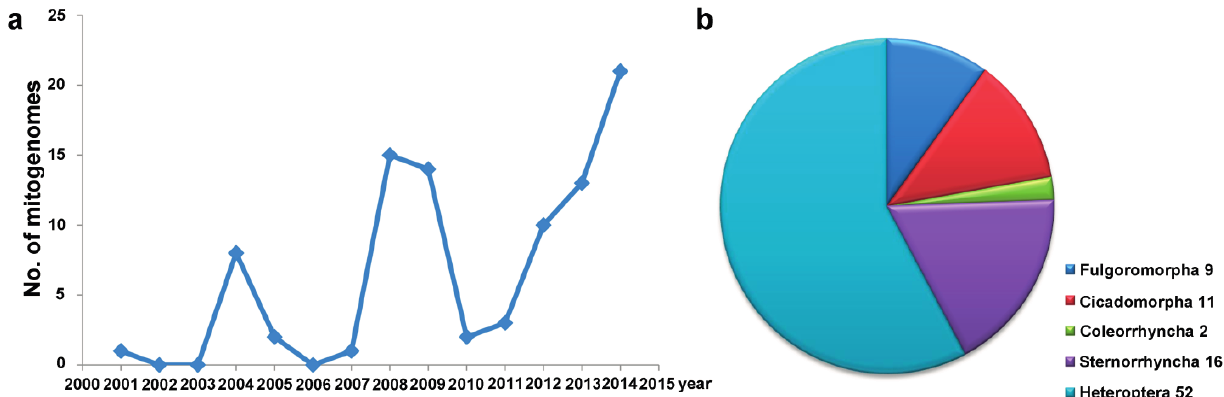
Figure 1. Accumulation of mitogenome data from Hemiptera. ( a ) The number of species sequenced in each year is represented by the blue line; ( b ) The number of species sequenced in each suborder is represented by the different pieces of the pie